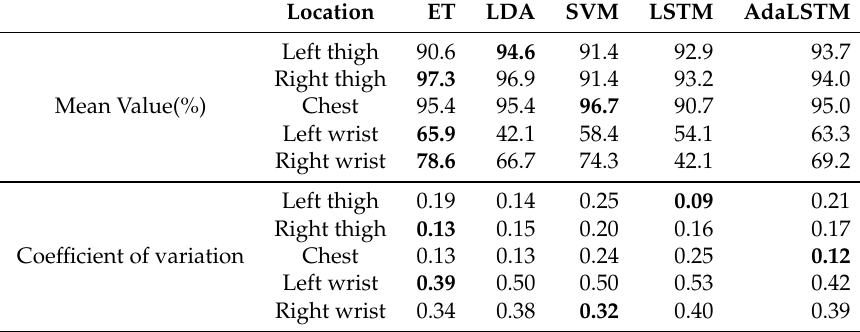
Table 5. Comparison between the mean value and coefficient of variation for F 1 score of detecting four lying postures for different sensor placements and classifiers including Ensemble Trees